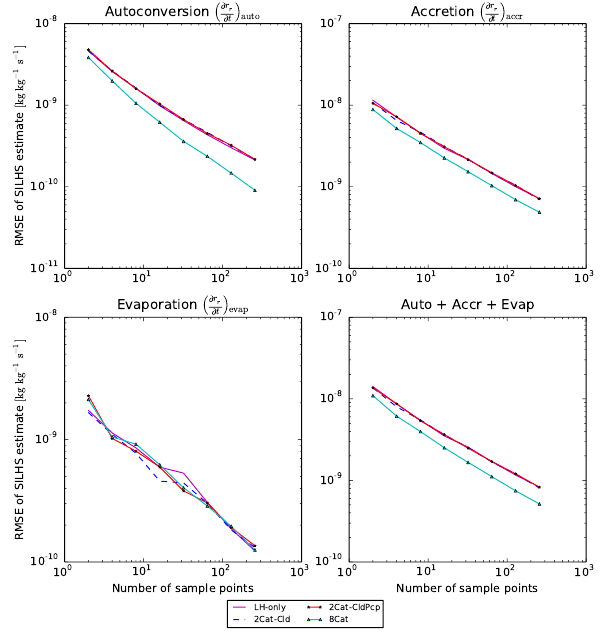
Figure 6. DYCOMS-II RF02: time-series plots of the four tenden- cies at the importance sampling level. The simulations in these plots use 32 sample points. The time range plotted includes minutes 161 to 360 of the simulation. The evaporation process is poorly sampled in all three sampling methods, but it is a relatively small term and makes a much smaller contribution to the sum of the three processes than autoconversion and